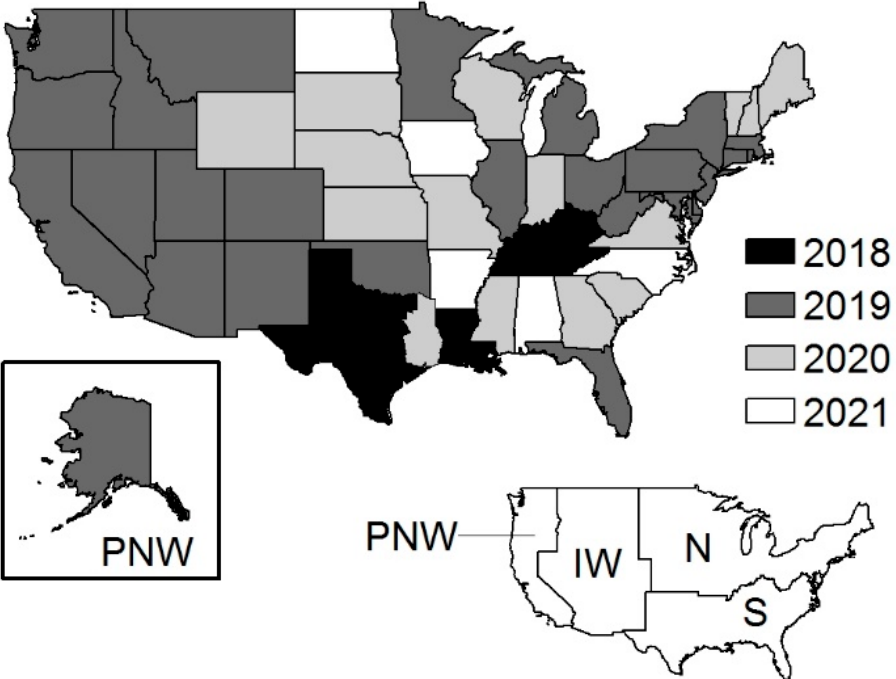
Figure 1. Inventory years included in the study by state and extent of the Interior West (IW), Northern (N), Pacific Northwest (PNW), and Southern (S) inventory regions. Table 1. Proportion of observations with an end digit of zero or five (P 0,5 ) and associated 99% lower (LCL) and upper (UCL) confidence limits by attribute and region.